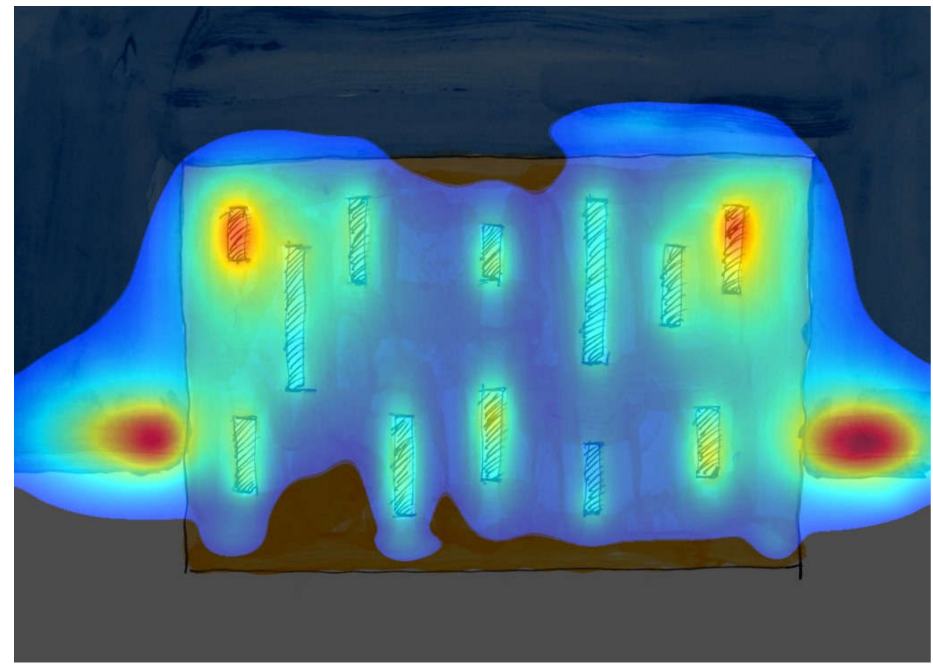
Figure 8. Heat map for contemporary building with unaligned vertical slit windows.